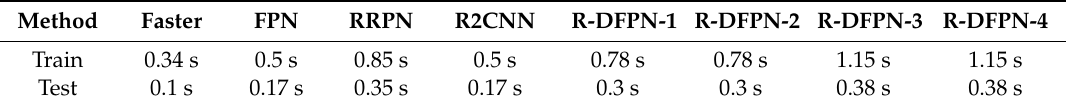
Table 2. Training and testing time for each method.